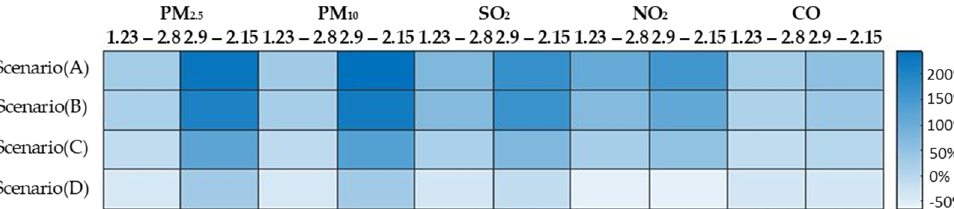
Figure 7. Comparison of Scenarios (A), (B), (C), and (D) with observations. The color refers to (observation − simulation)/observation.